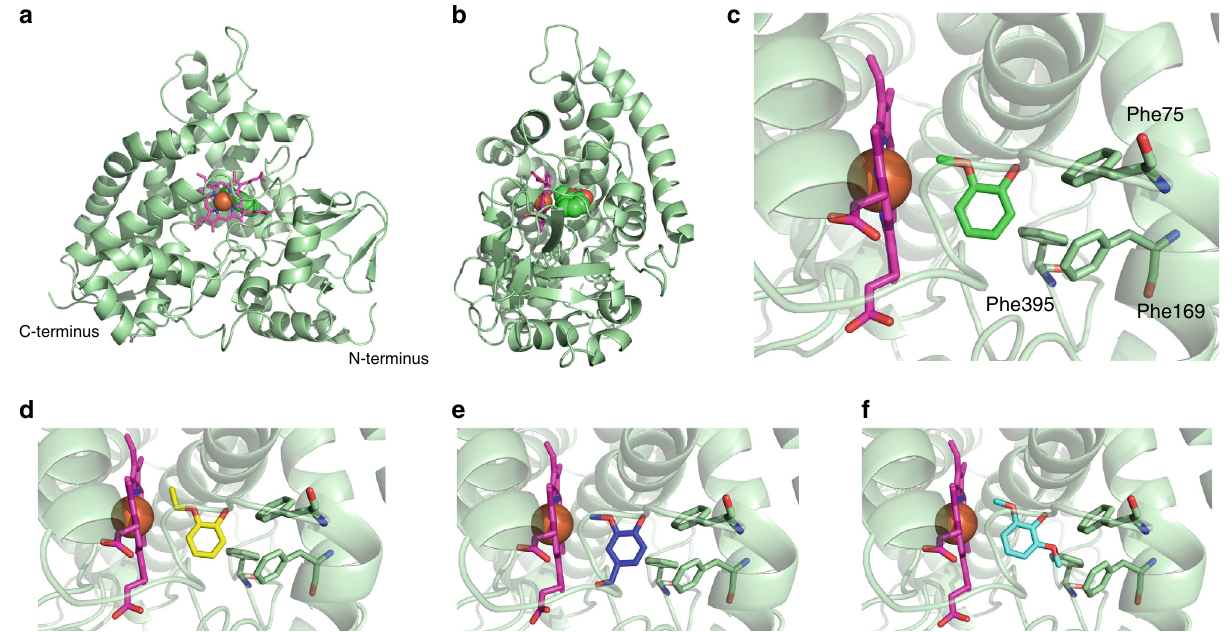
Fig. 2 Crystal structures of GcoA, illustrating the substrate binding mode. a , b The general architecture of GcoA is shown in cartoon representation highlighting the relative positions of the buried heme (pink) and bound guaiacol (space- fi lling). c – f Comparisons of ligand-bound structures of guaiacol (green), guaethol (yellow), vanillin (blue), and syringol (cyan) showing key hydrophobic residues lining the active site